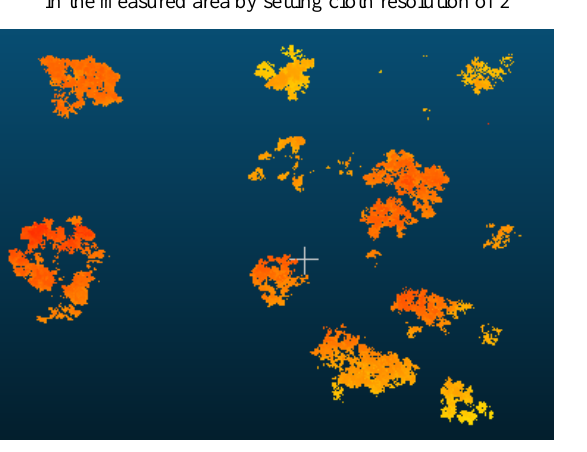
Figure 11.The extraction of non-ground seed points using CSF in the measured area by setting cloth resolution of 1